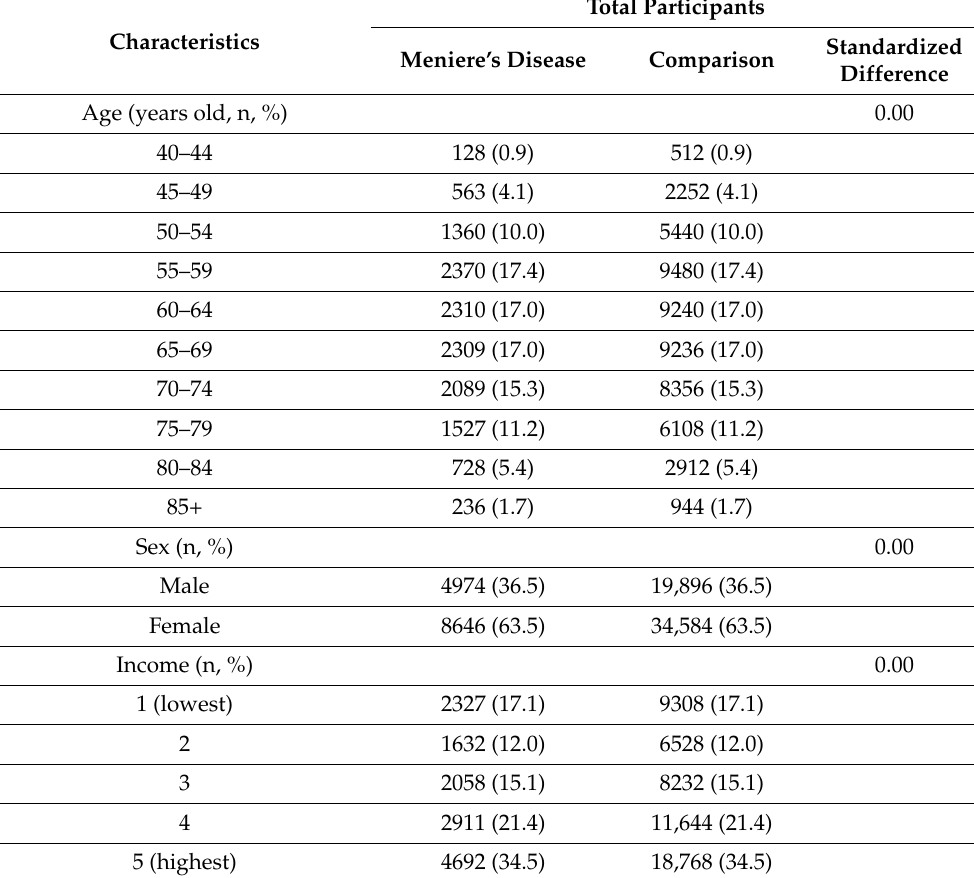
Table 1. General Characteristics of Participants. BMI body mass index, kg/m 2